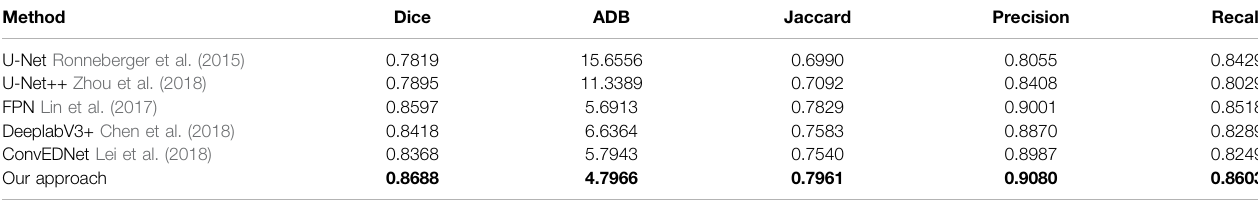
TABLE 1 | Measurement results of different segmentation methods on the BUSZPH dataset. Our results are highlighted in bold. Method Dice ADB Jaccard Precision Recall U-Net Ronneberger et al. (2015)